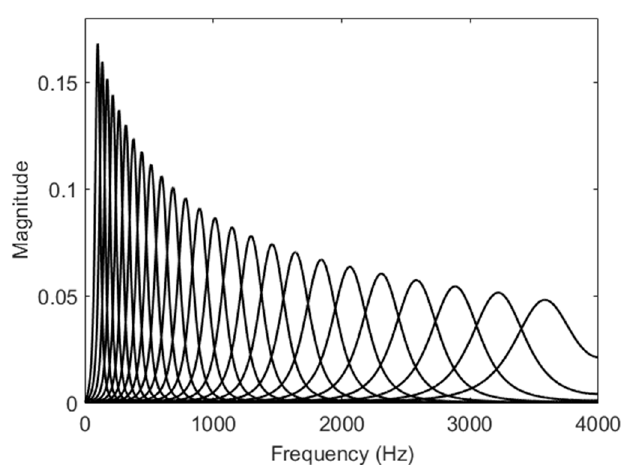
Figure 2. Normalized 25 gammatone filter banks.